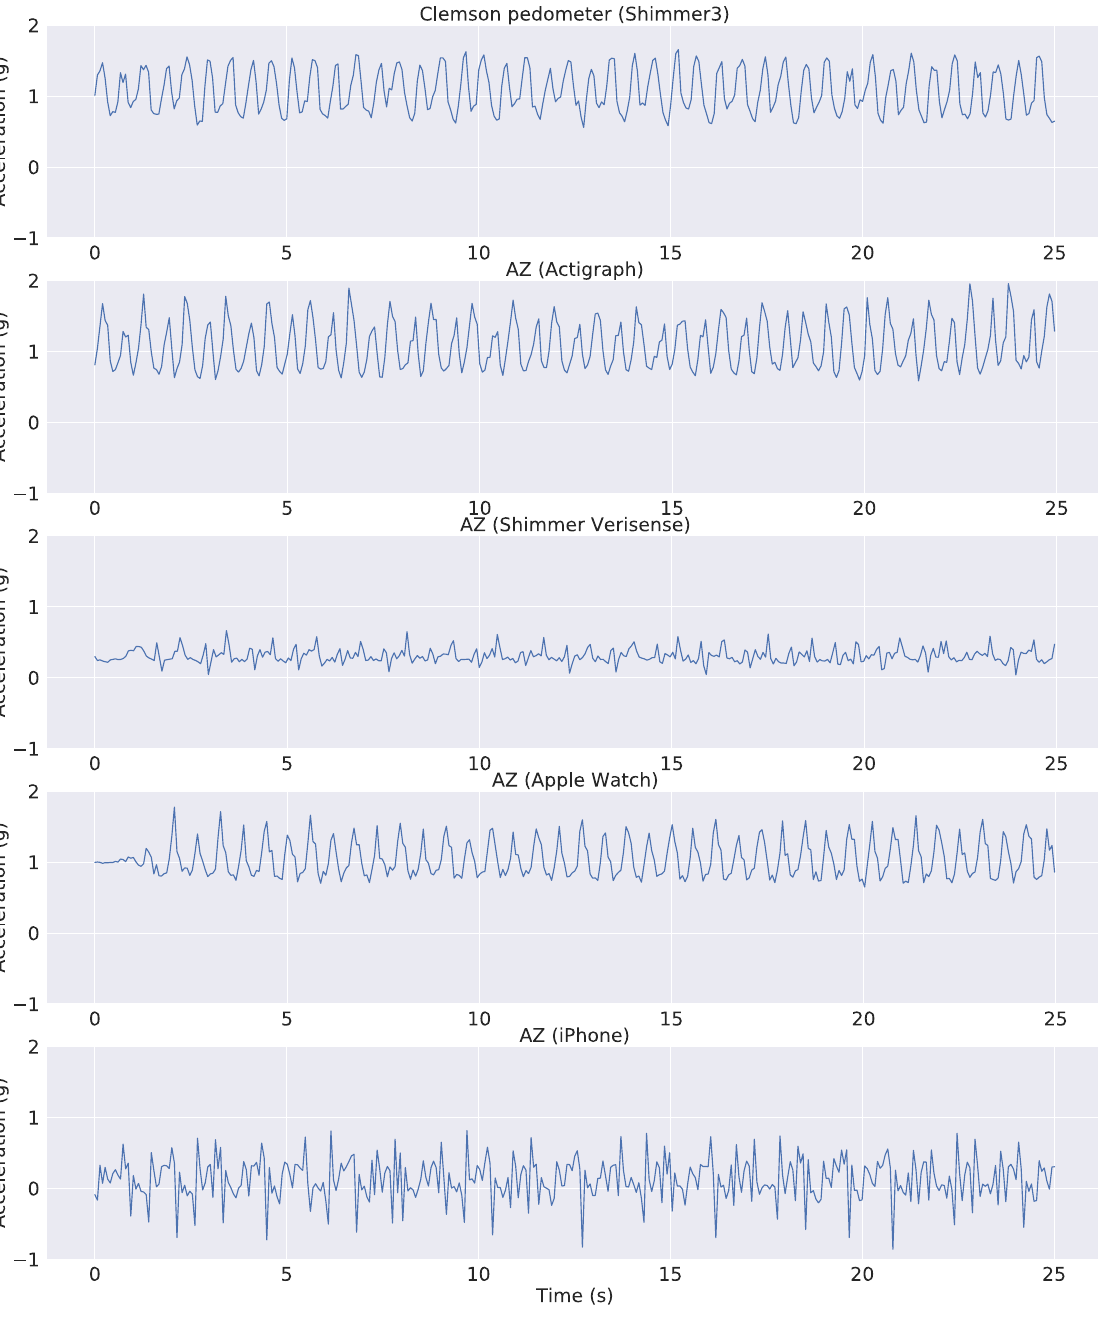
Figure 3. Representative ENMO signals from public and independent datasets. The first panel indicates data from the public Clemson dataset. The other panels illustrate AstraZeneca dataset for different devices used in the